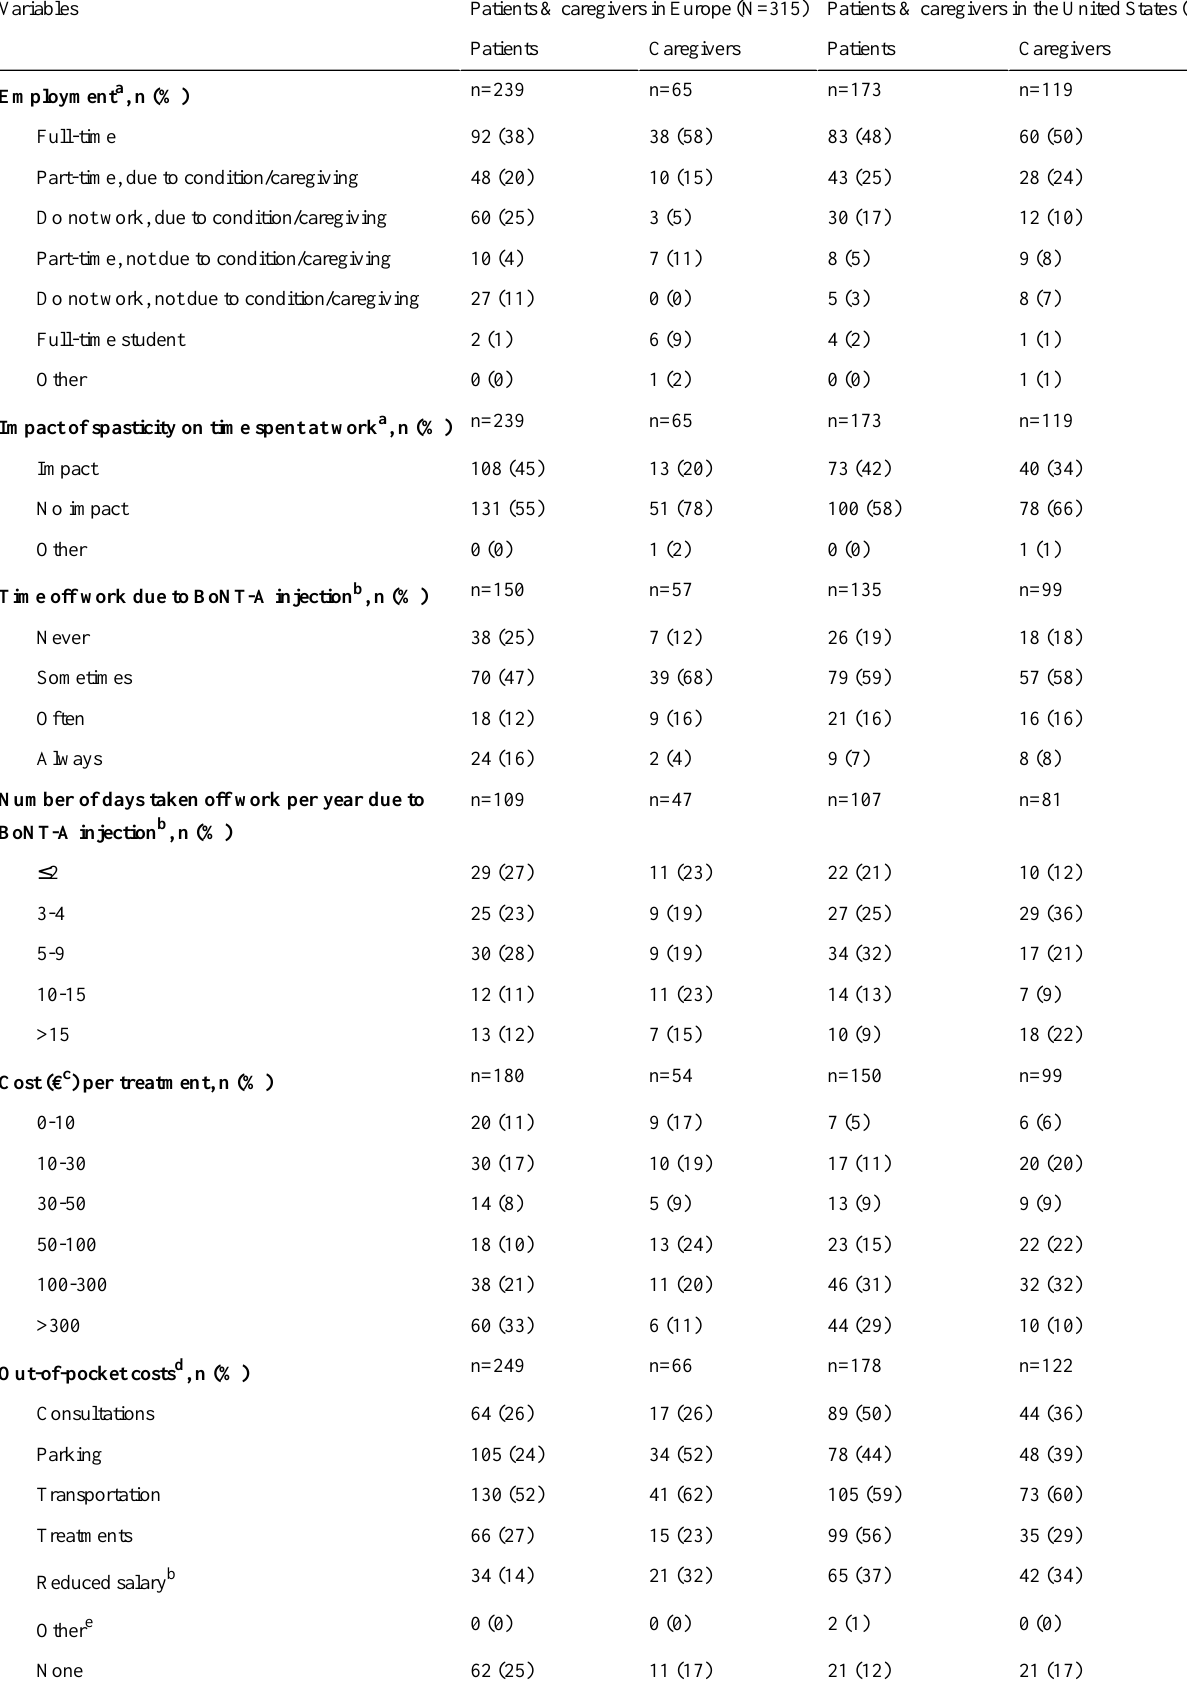
Table 3. Burden of spasticity and botulinum neurotoxin type A (BoNT-A) treatment, and the perceived benefits of fewer BoNT-A treatments, for patients and caregivers in Europe and the United States